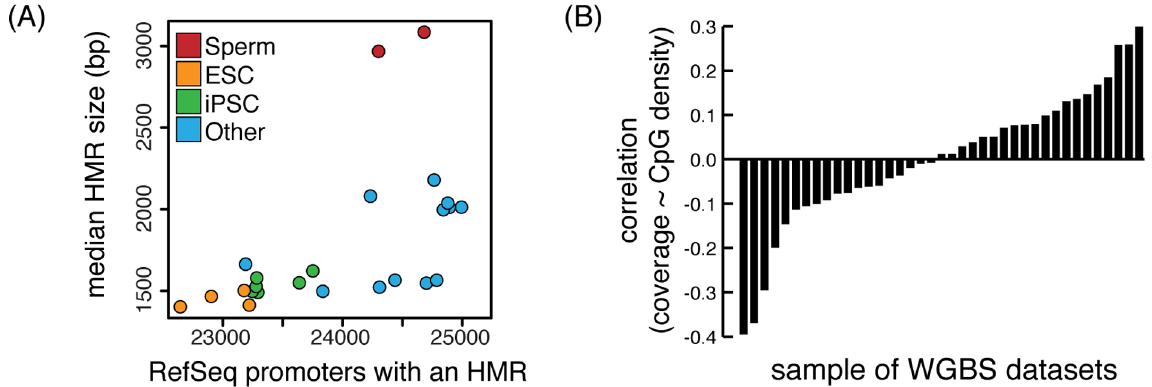
Figure 4. Comparing biological and technical features of methylome data. (A) Human methylomes are clustered according to the number and size of promoter HMRs. (B) Correlation between depth of coverage at CpG sites and CpG densities in 1 kb windows for a subset of human methylomes from MethBase. X-axis indicates the index of methylomes sorted by their correlation coefficients. See Table S1 for p -values and the list of samples.